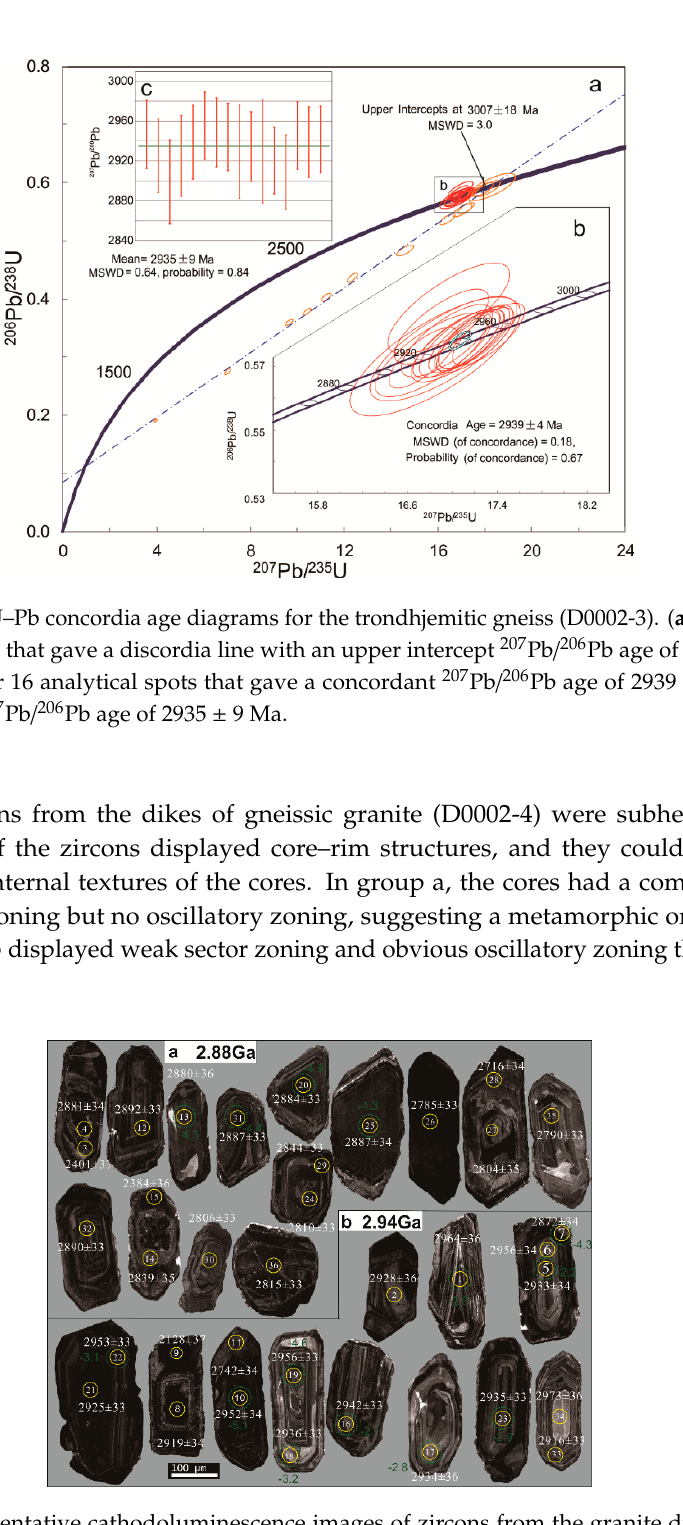
Figure 8. Representative cathodoluminescence images of zircons from the trondhjemitic gneiss (D0002-3). Symbols are as in Figure 4.